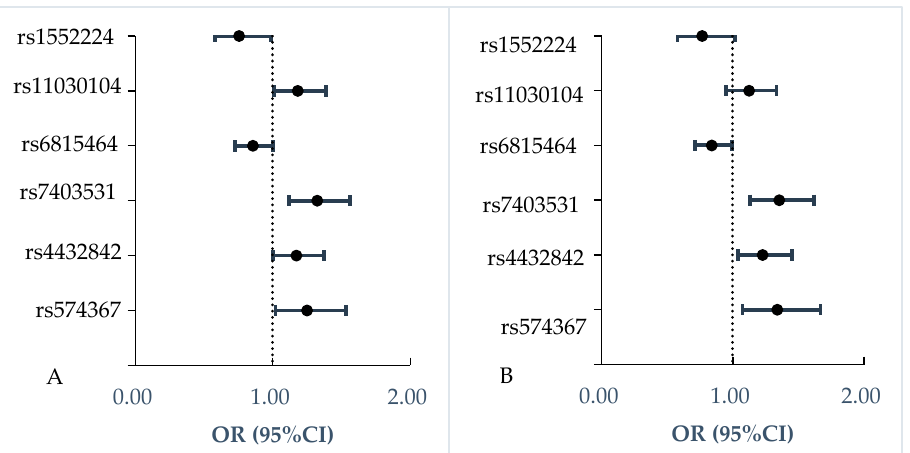
Figure 1. Association of six SNPs with insulin resistance. ( A ) Model 1 was logistic regression model to analyze the association of individual SNP with quantitative traits without adjusting for any covariates. ( B ) Model 2 was logistic regression model to analyze the association of individual SNP with quantitative traits adjusting for gender, economical status, education levels, BMI, waist circumference, sedentary time, exercise, whole cereal and beans intake levels, livestock and poultry intake levels, drinking, and smoking.